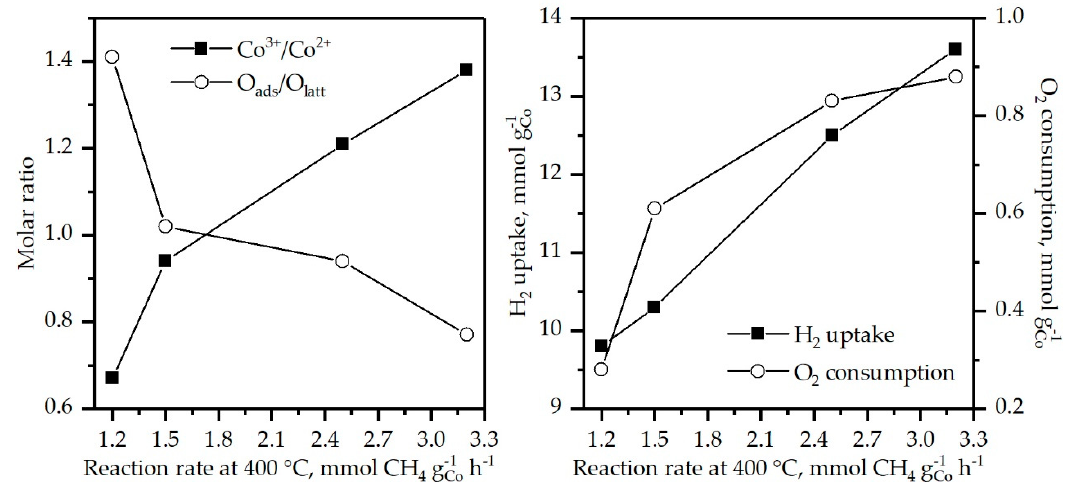
Figure 11. Relationship among specific reaction rate and: surface Co 3 + / Co 2 + and O ads / O latt molar ratios ( left ); low-temperature H 2 uptake from H 2 -TPR and low-temperature O 2 consumption from CH 4 -TPRe ( right ).